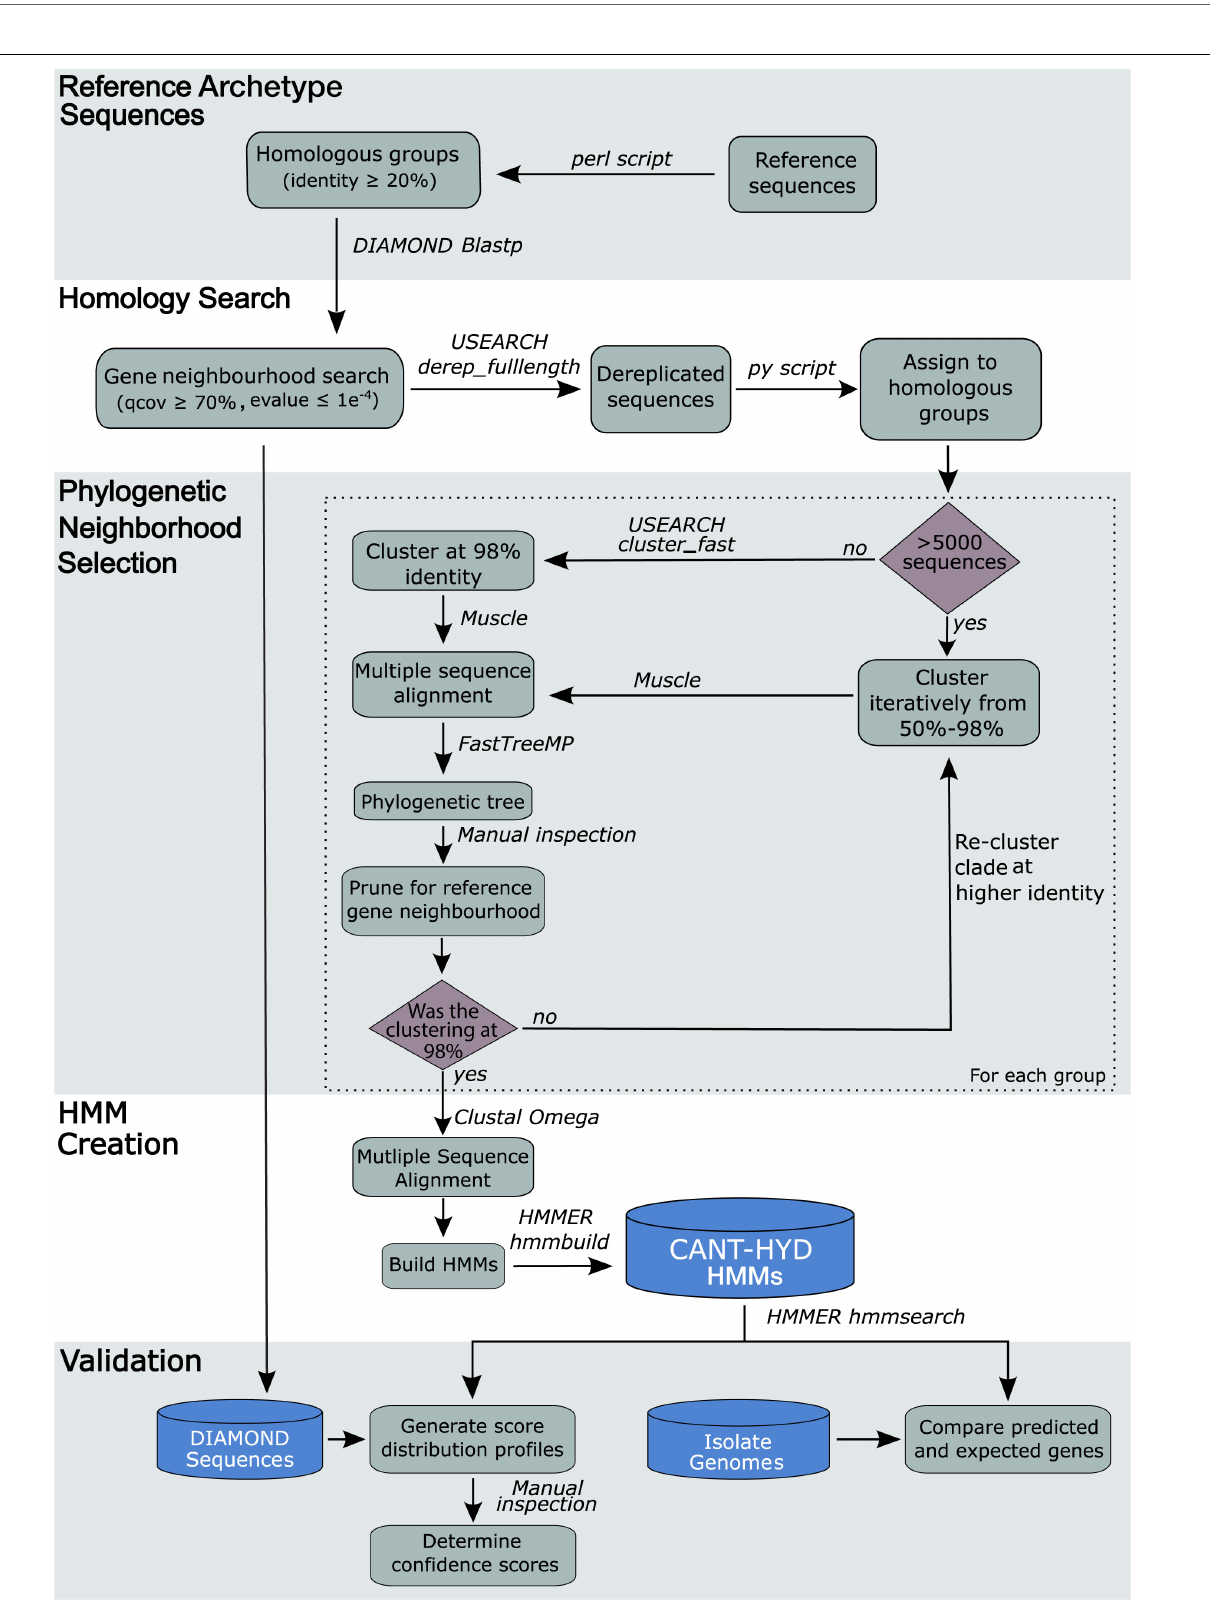
Frontiers in Microbiology |